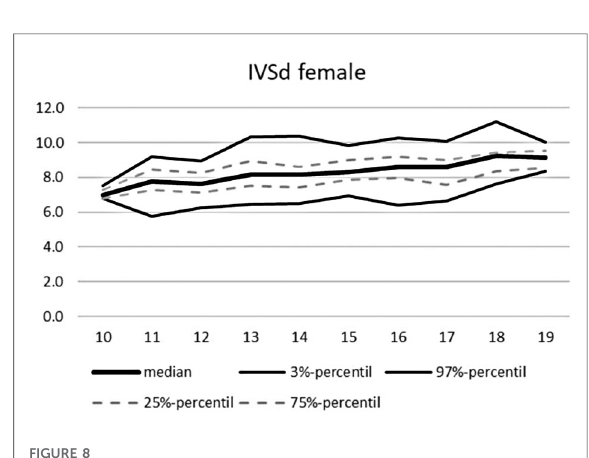
FIGURE 5 Echocardiographic values in dependence of age, IVSs male.